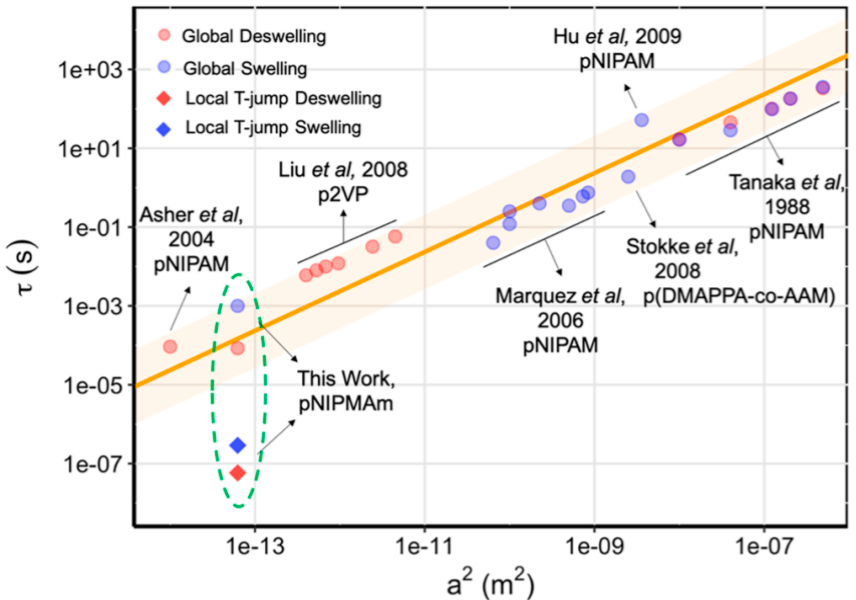
Figure 4. Swelling − deswelling kinetics (log–log correlation plot) of typical-size NGs observed using the Tanaka model by the correlation between the particle deswelling − swelling time constant, τ , and the square of the particle radius, a 2 . Reprinted with permission from Reference [49]. Copyright 2019 American Chemical Society.